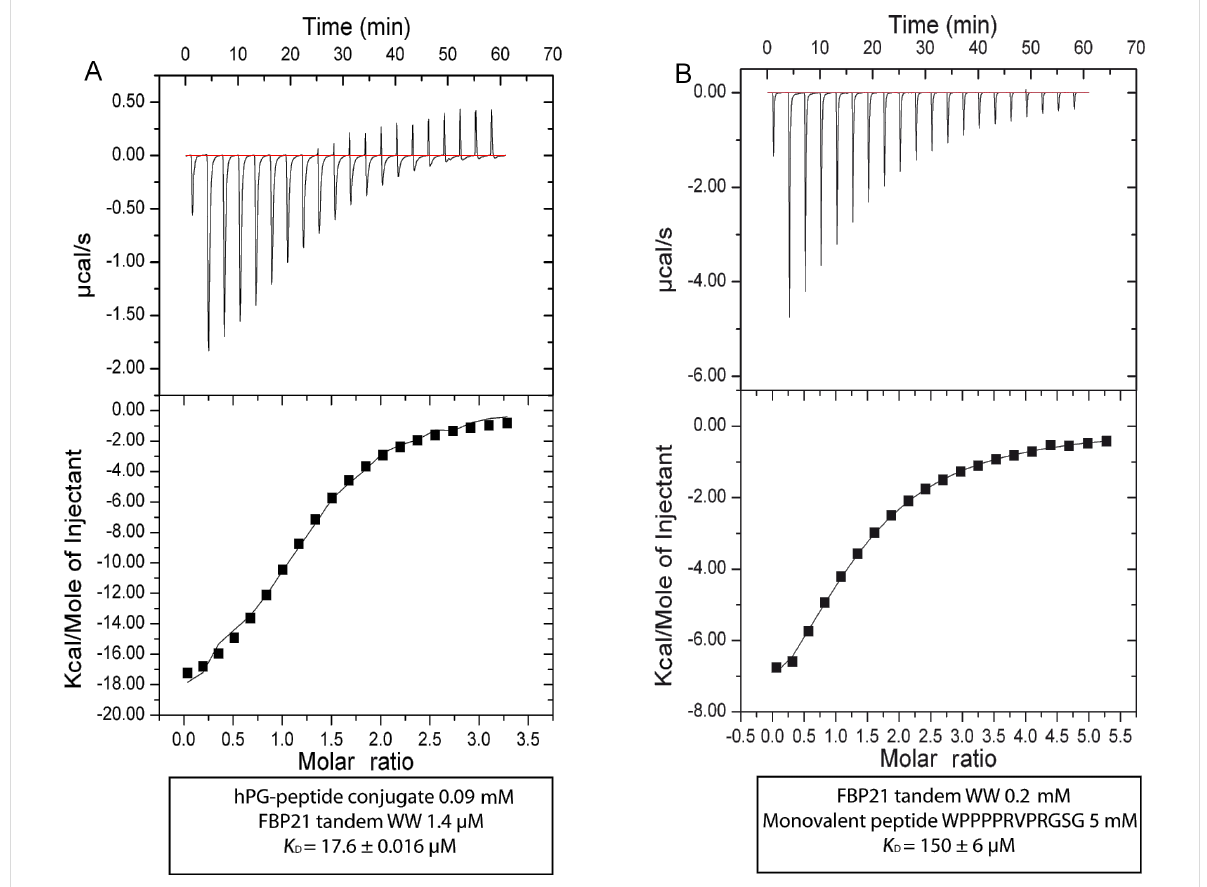
Figure 2: A) ITC measurement with FBP21-tWW and hPG-peptide conjugate 2 , the K D value is 17.6 ± 0.016 μ M. B) ITC measurement with FBP21-tWW and monovalent peptide shows a K D of 150 ± 6